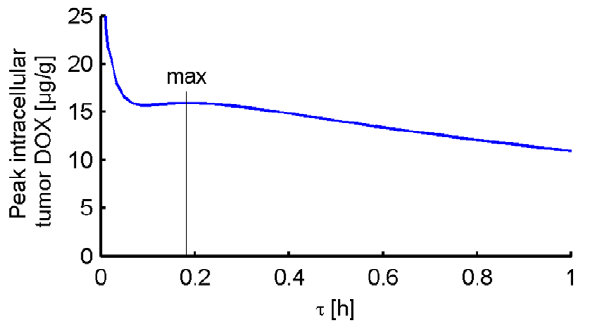
Figure 10. Optimization of release time constant for TSL-e. The optimum (optimum indicated by line at , 11 min) is where contribution of release from extravasated TSL-e towards drug delivery is maximal (intended delivery mechanism). While higher intracellular concentra- tions are observed at very short release time constants, this is due to contribution from intravascular release, i.e. the TSL-e become equivalent to TSL-i .